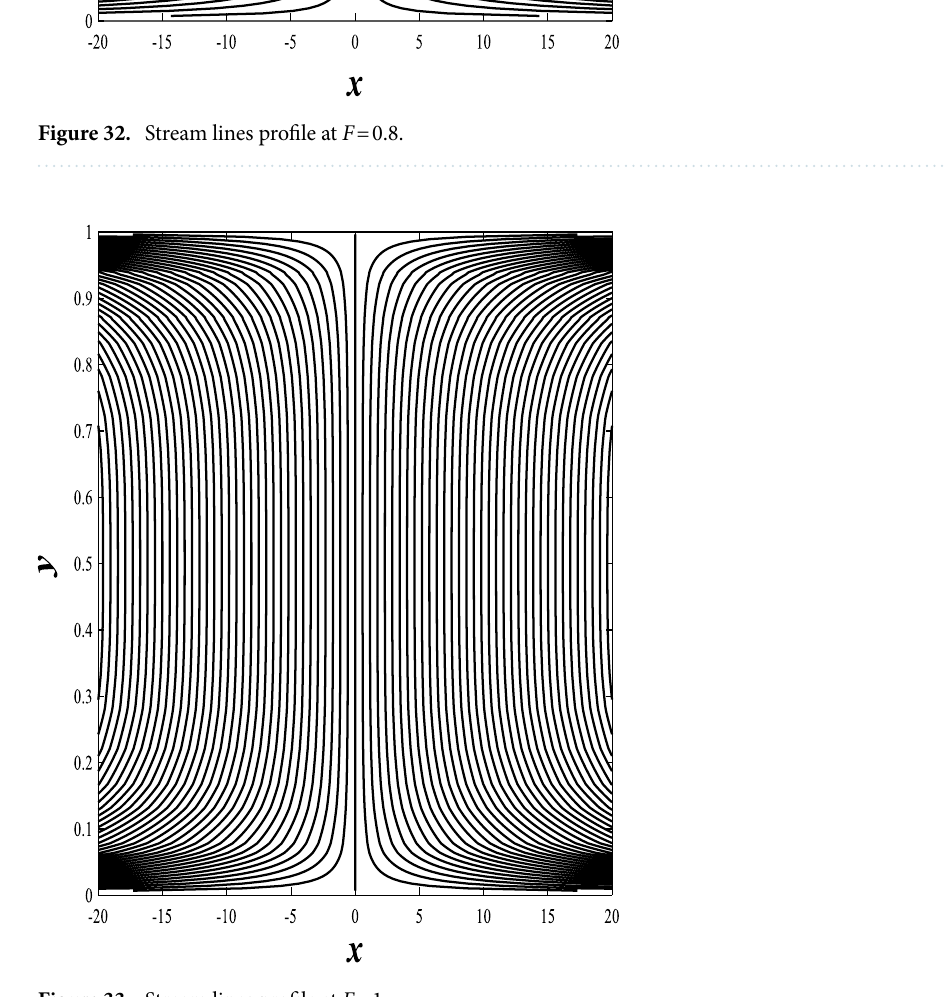
Figure 33. Stream lines profile at F =